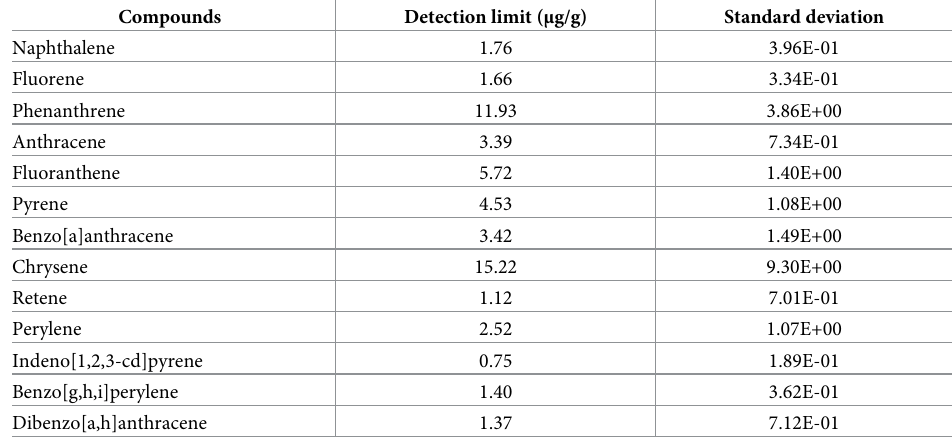
Table 3. The detection limits and reproducibility (standard deviation) of the available PAHs in the